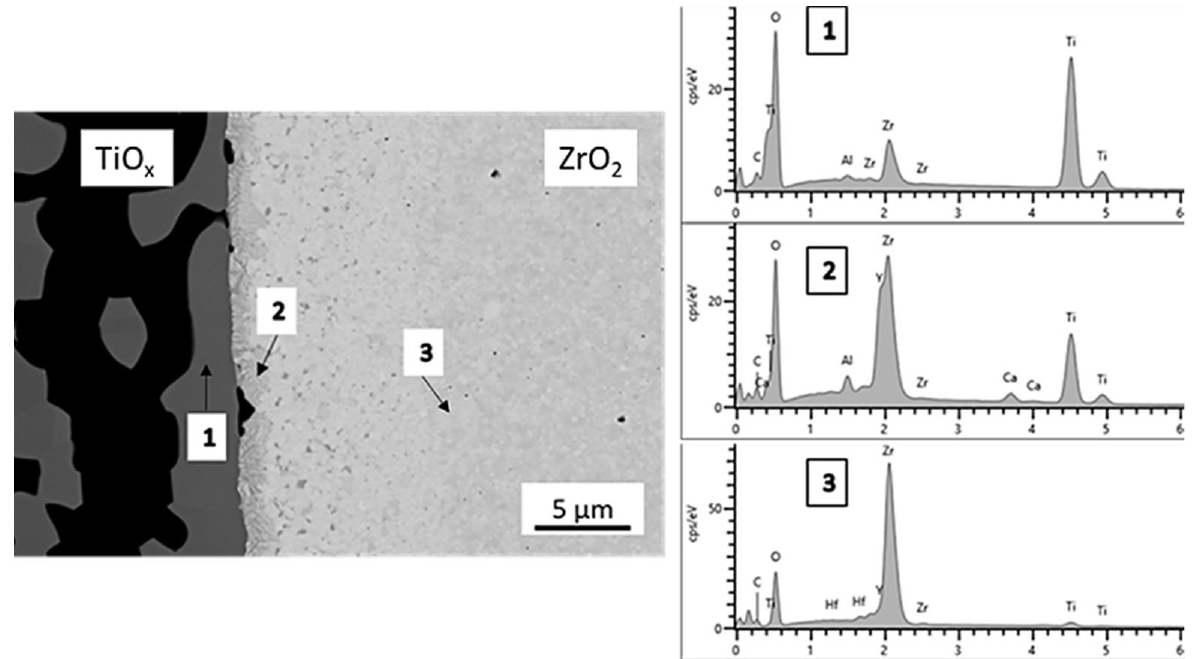
Figure 16. Interphase formation between ZrO 2 and TiO x in the sintered composite .